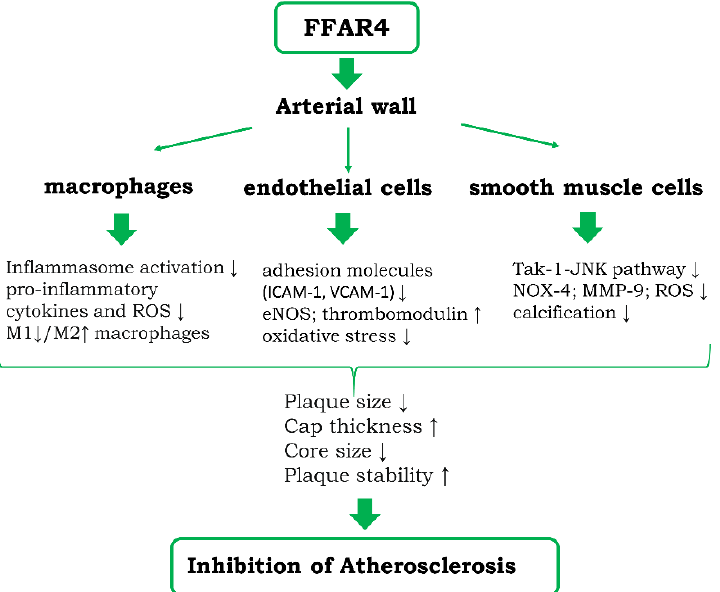
Figure 2. Diagram showing the potential cellular and molecular mechanisms of anti-atherosclerotic actions of FFAR4 within the vessel wall. Potential indirect action of FFAR4 stimulation on atherosclerosis via inhibition of steatosis and steatohepatitis is detailed in the text.